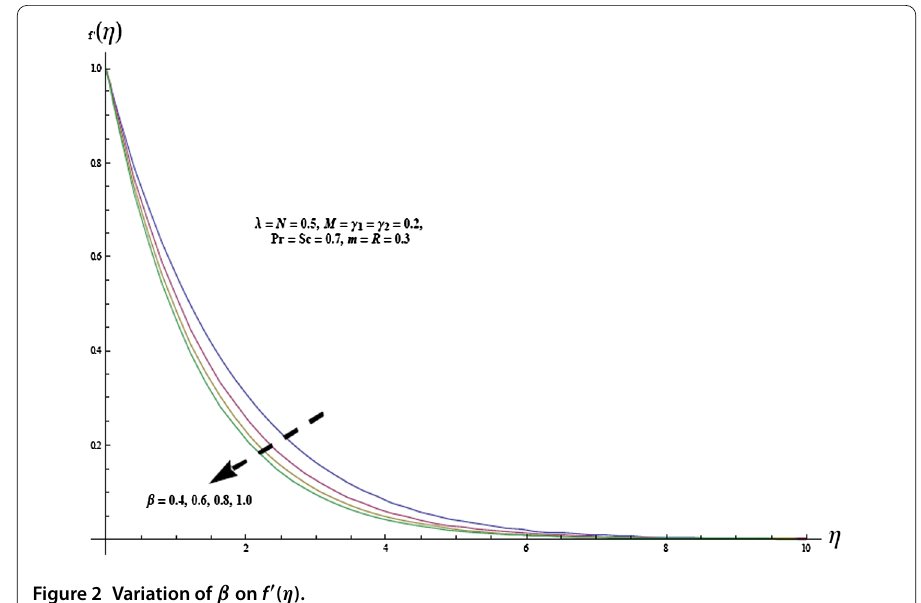
Figure 2 Variation of β on f (cid:2) ( η ).